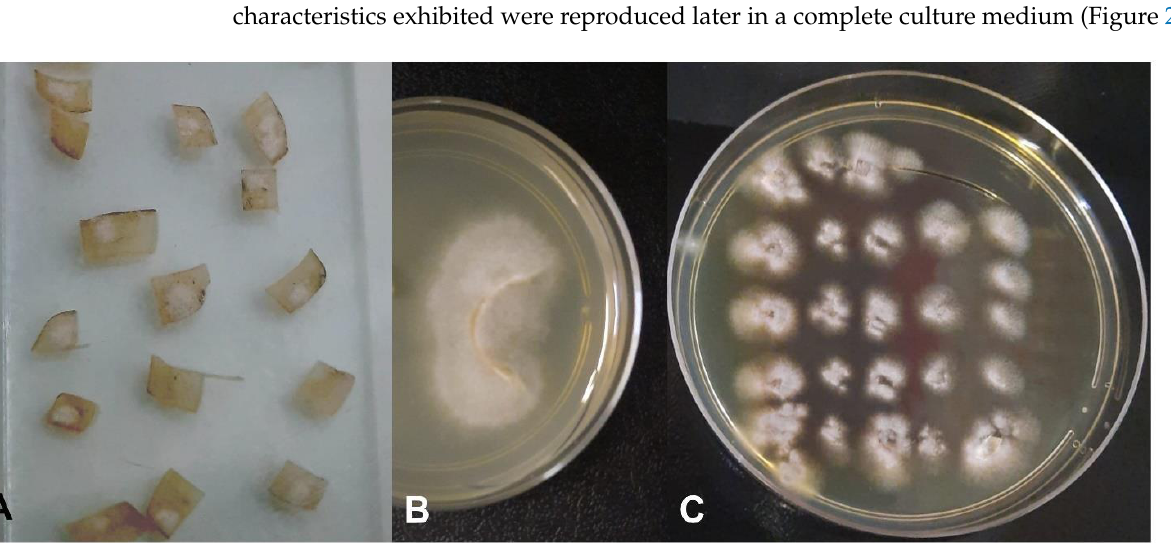
Figure 2. Ability of Neocosmospora keratoplastica to grow on the human nail using it as the only substrate. ( A ) Macroscopic growth on the nail surface in four days at 25 °C in a moist chamber; ( B ) the pour plate technique with the inoculum incorporated into the YNB agar base, without adding of carbon sources, proving fungal growth restricted to the health nail; ( C ) Print of infected nail fragments on Sabouraud dextrose agar complete medium.